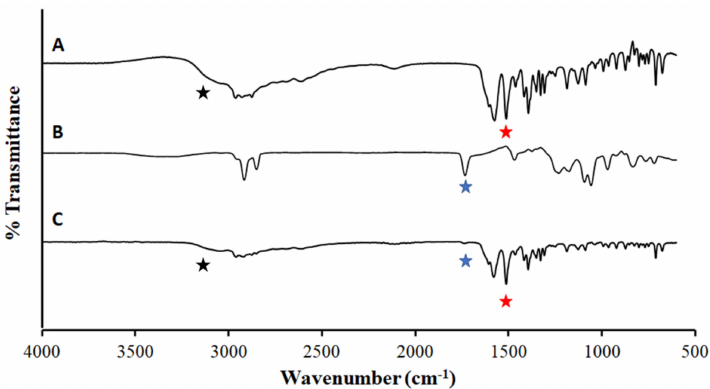
Figure 6. ATR-FTIR spectra of excipient materials of ( A ) L-isoleucine, ( B ) DPPC, and displayed in conjunction with the ILDF microparticles ( C ).